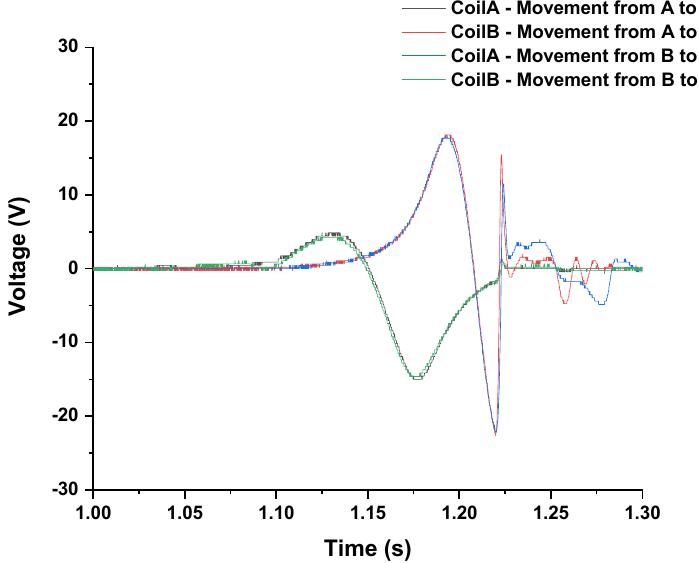
Figure 5. Output voltage of each coil (Coils A and B) in a freefall test, when magnets move in the direction from Coil A to Coil B (A–B) or vice-versa (B–A), the magnets pass through coils in 250 ms.